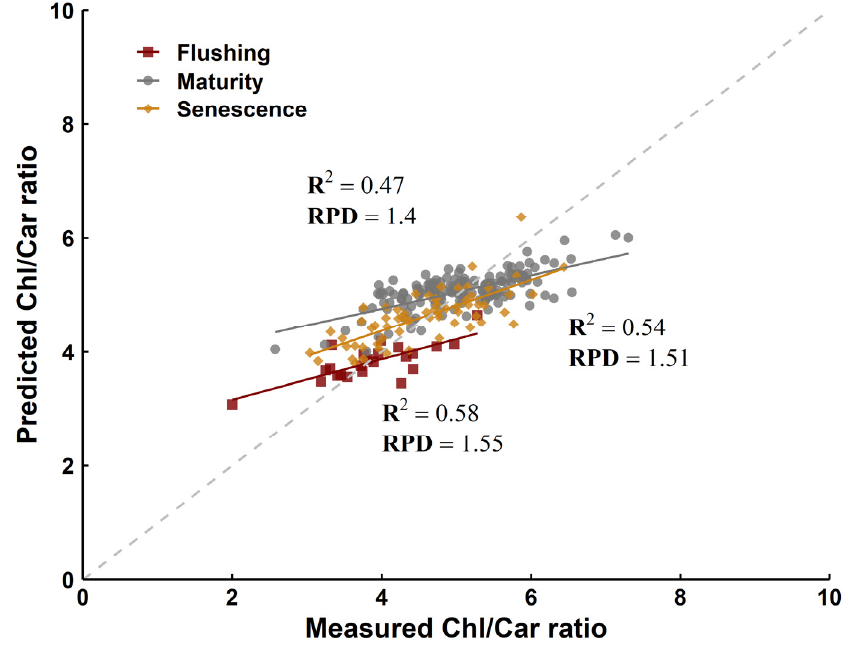
Figure 4. Performance of the best developed index for tracing the Chl/Car ratio in the two field- measured datasets (Naeba and Nakakawane) at distinctive phenological stages.